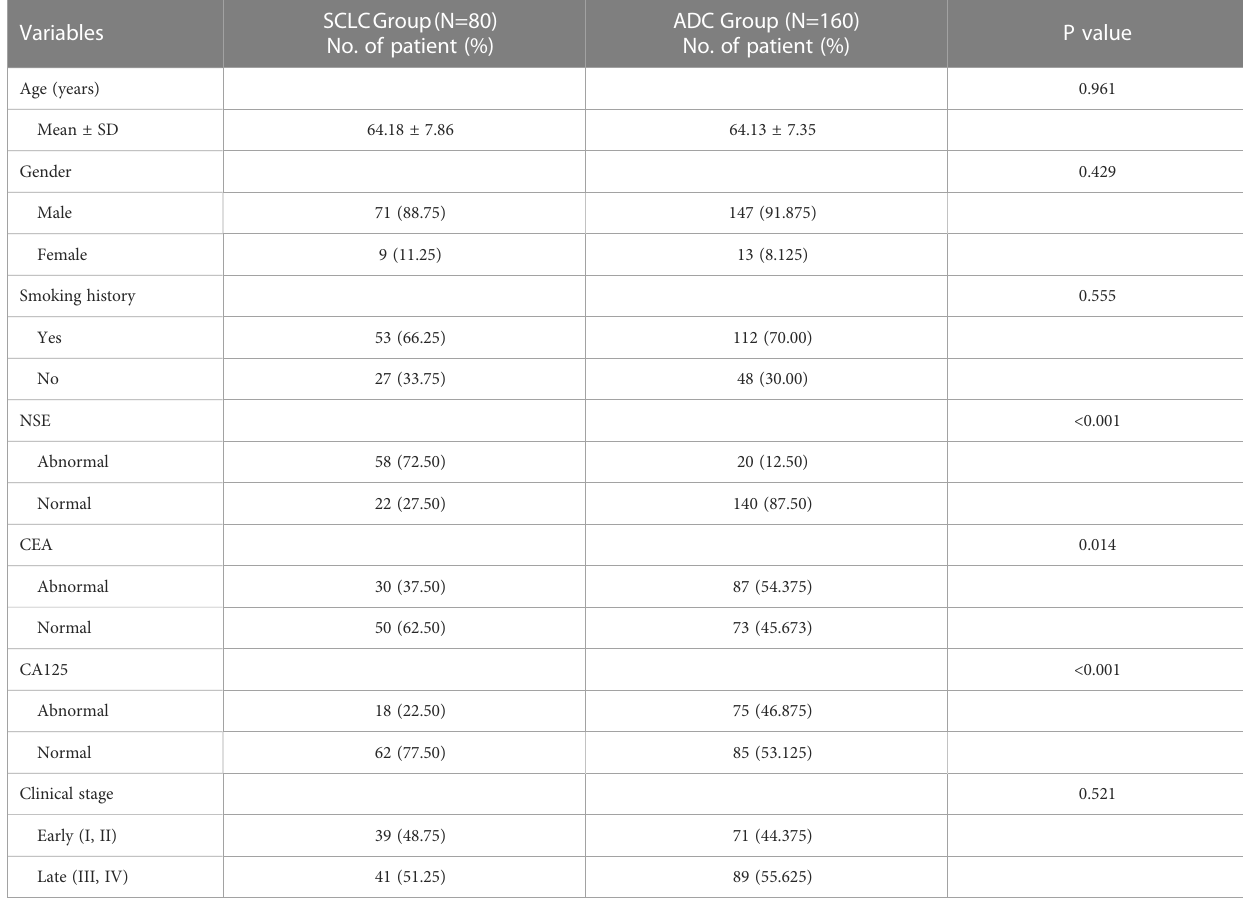
TABLE 1 Comparison of clinical data in PSCLCs and